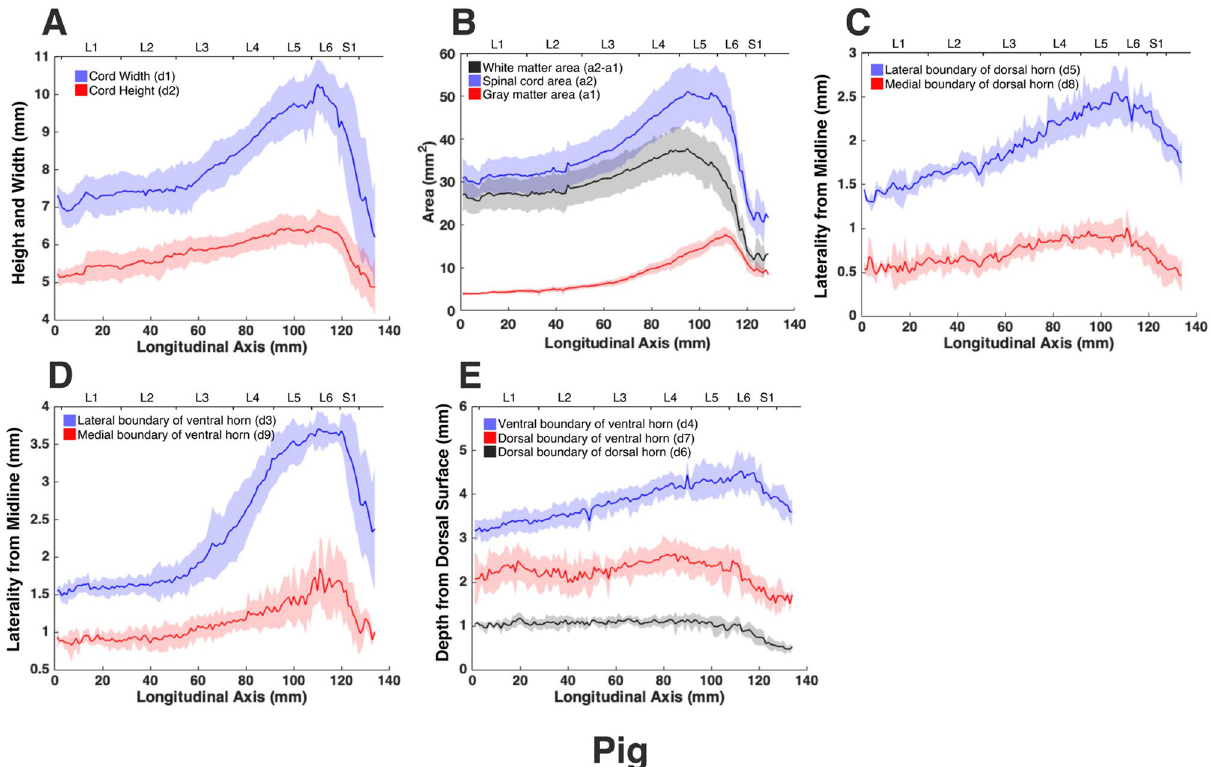
Figure 10. Measurements of cross-sectional dimensions of the spinal cord and locations of the ventral and dorsal horns of pig spinal cord. Presented data are based on n = 6 specimens. Solid lines represent the mean and the shaded regions represent the mean ± standard deviation. ( A ) Spinal cord width and height (d1 and d2, respectively in Fig. 7, left) across the lumbosacral cord. ( B ) Cross-sectional areas of the spinal cord and gray matter (a1, a2 in Fig. 7, right) across the lumbosacral cord. ( C ) Mediolateral distances from midline to the dorsal horn boundaries (d5, d8 in Fig. 7, middle). ( D ) Mediolateral distances from midline to the ventral horn boundaries (d3, d9 in Fig. 7, middle). ( E ) Depth from the dorsal surface of the spinal cord of the ventral and dorsal horn boundaries (d4, d7, d6, in Fig. 7,